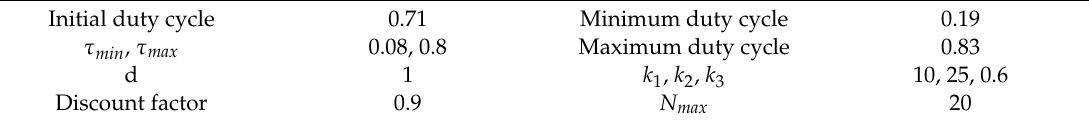
Table 2. Operational parameters of the proposed Q-learning-based GMPPT method.